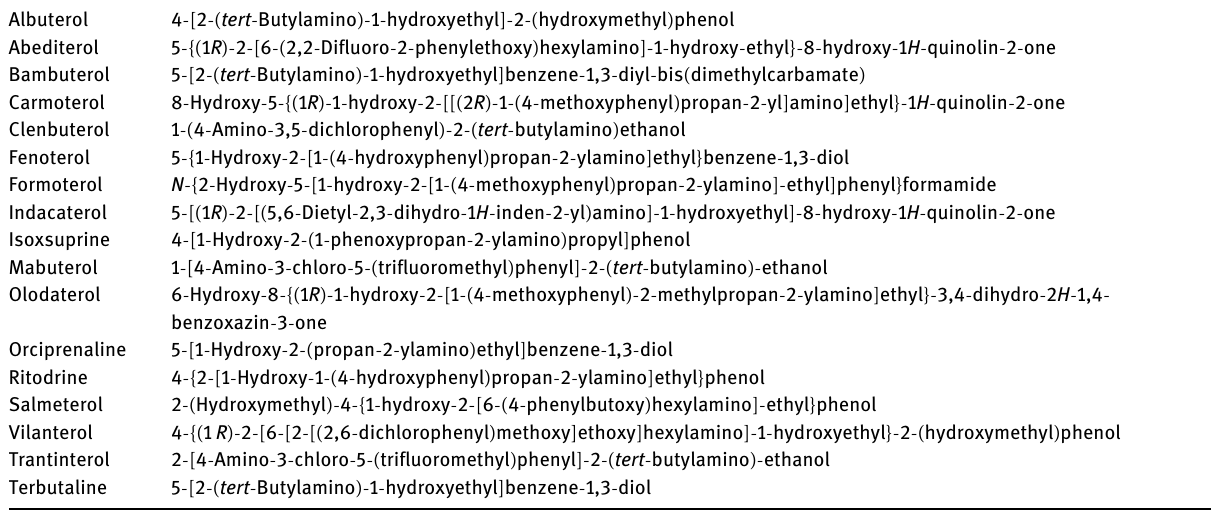
Table 1: Chemical IUPAC names of selected β 2 - agonists Albuterol